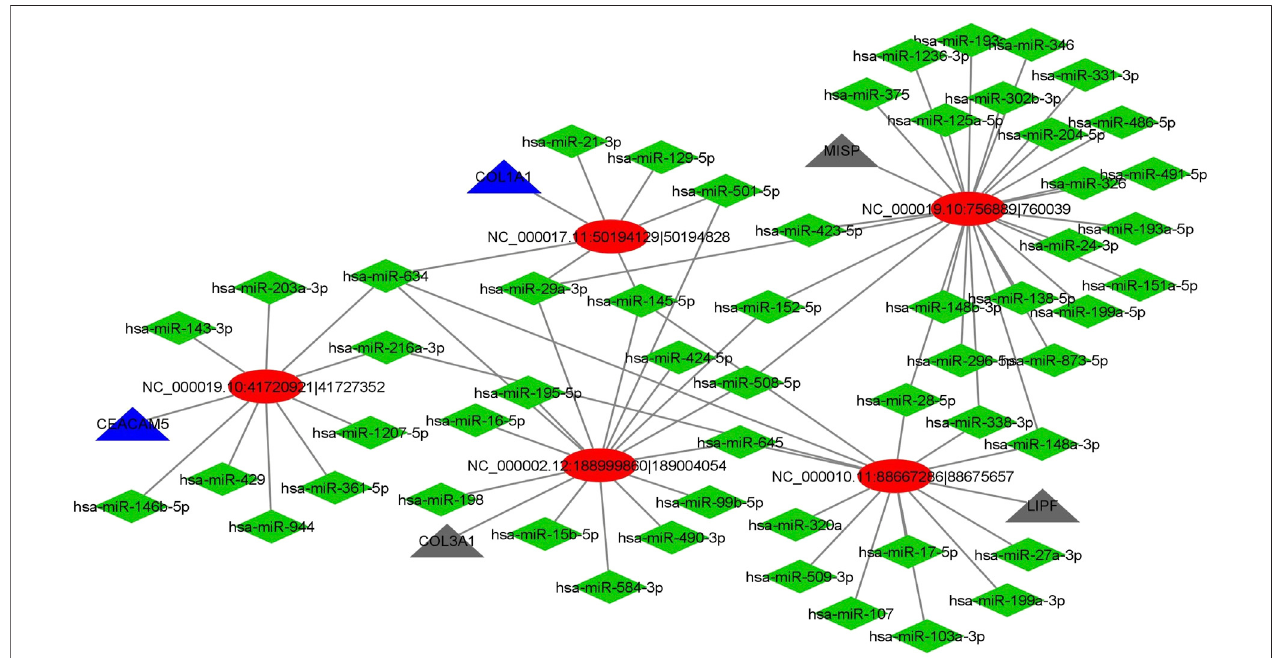
FIGURE 5 | CircRNA-miRNA-gene interaction network. Ellipse shape indicates circRNA, diamond shape indicates miRNA while triangle indicates gene. Blue triangle indicates genes related to GC and black triangle indicates other genes.